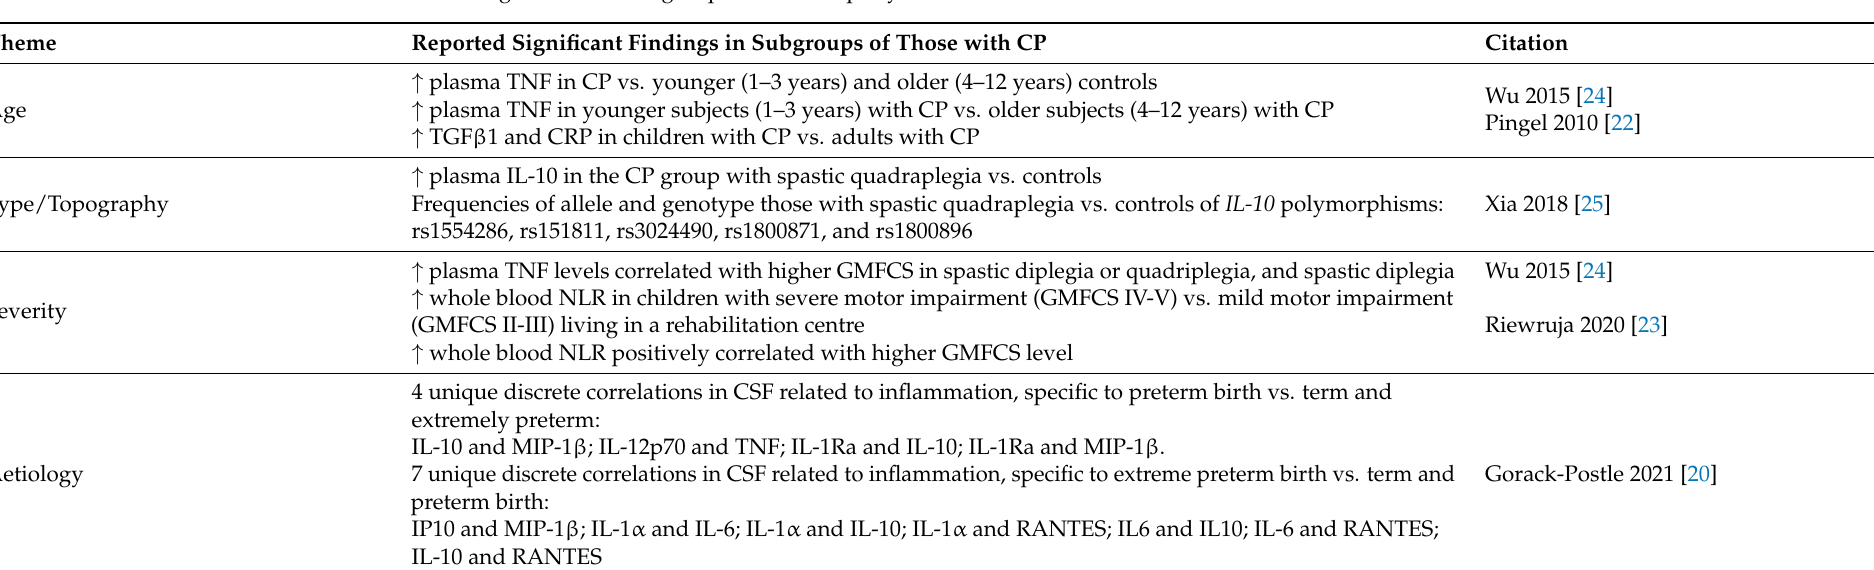
Table 2. Main findings related to subgroups of cerebral